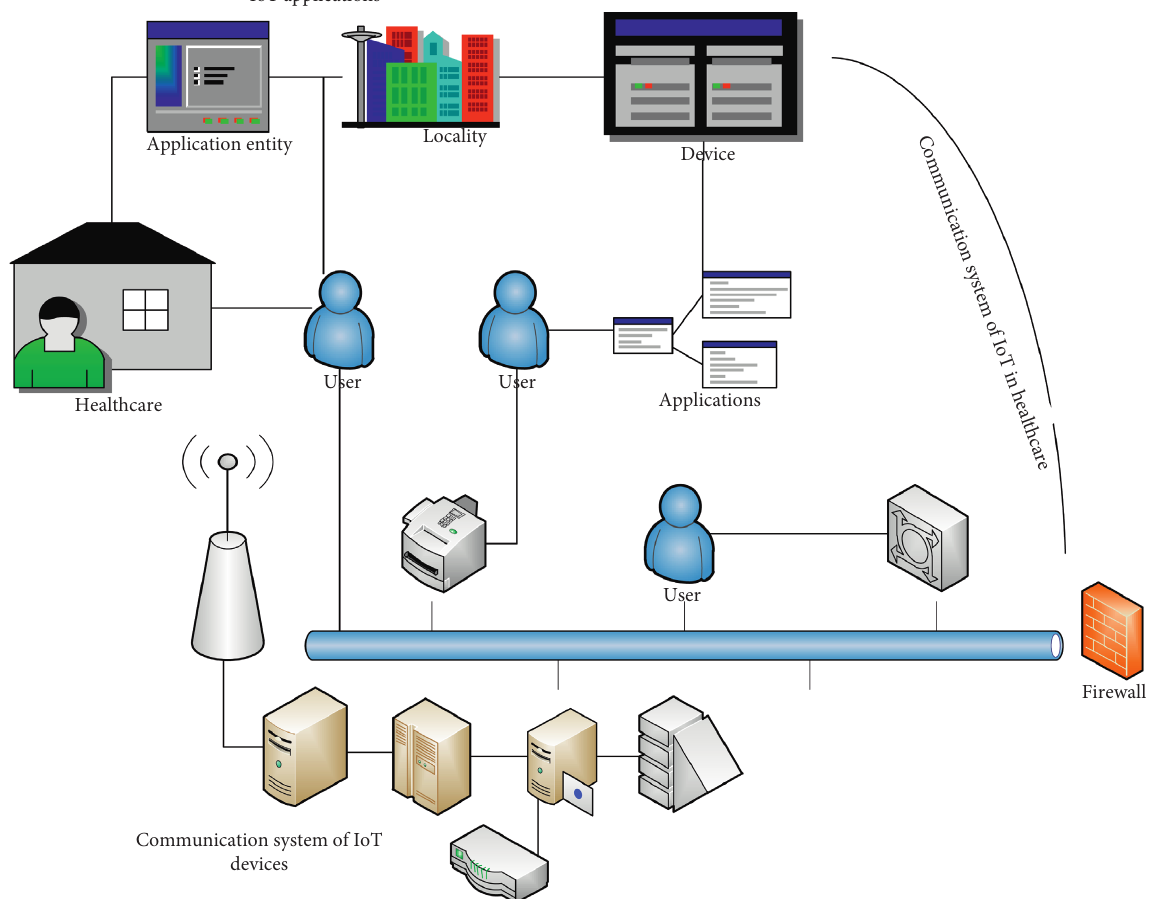
Figure 1: IoT-based architecture of the healthcare